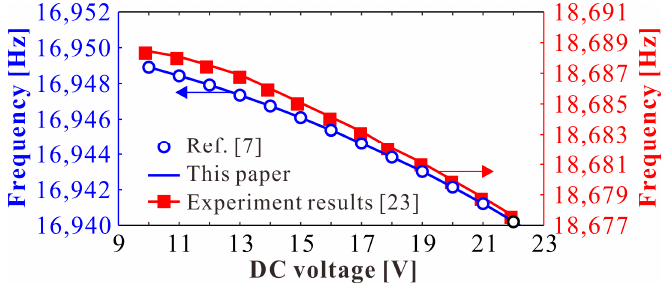
Figure 9. Natural frequency compared with experiment results in Reference [23].